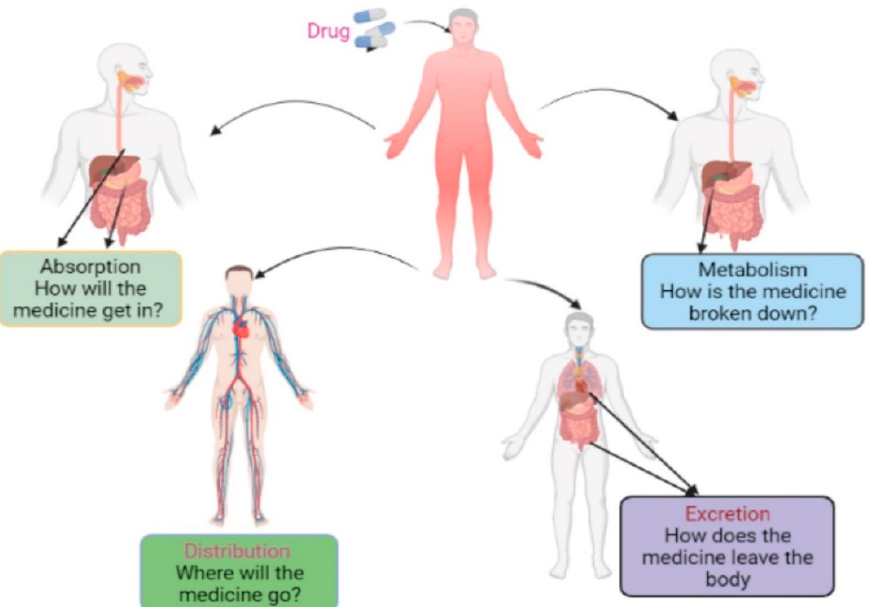
Figure 4. Schematic representation of ADME approaches required during the drug design process. Herein, the absorption, distribution, metabolism, and excretion process utilized by a drug in human systems are explained.